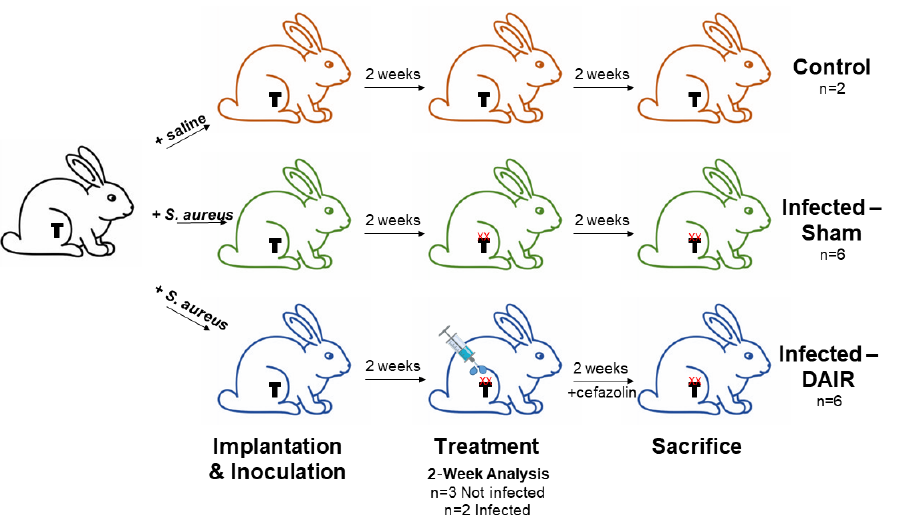
Figure 2. Experimental schematic: all rabbits were implanted with a titanium press-fitted or cemented tibial implant; control and infected rabbits received an intra-articular injection of saline or Xen36, respectively, after capsule closure; 2 weeks later, when rabbits had a productive infection with biofilm (denoted with XX), they underwent either sham treatment or debridement, antibiotics, and implant retention (DAIR) treatment where they received an irrigation and debridement (I&D) and cefazolin antibiotics for 2 weeks; finally, rabbits were sacrificed 2 weeks post-treatment for post-mortem analysis of bacterial biofilm formation and bacterial